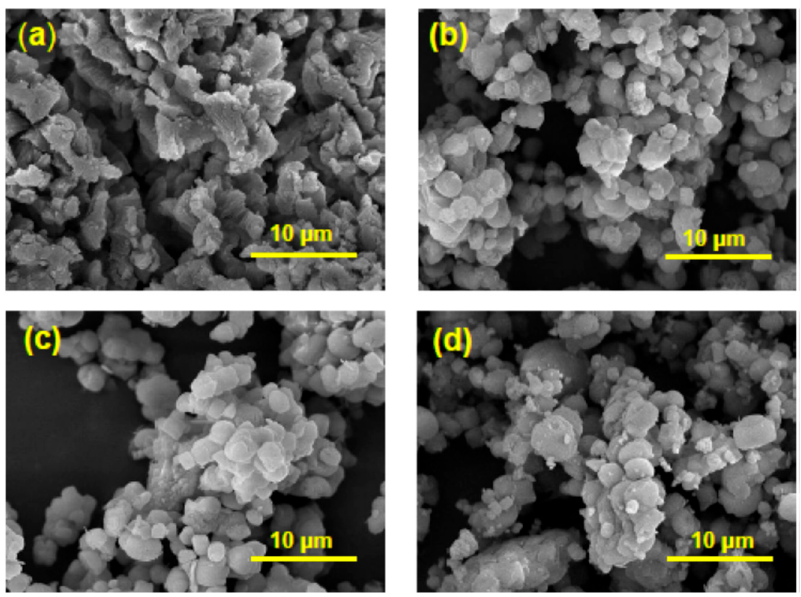
Figure 8. SEM images of ( a ) CaO, ( b ) 13XZ, ( c ) CaO/13XZ and ( d ) CaO-Zn/13XZ. The NH 3 -TPD curves of the 1# 13XZ, 2# CaO/13XZ and 3# CaO-Zn/13XZ fresh materials are shown in Figure 9a,b.